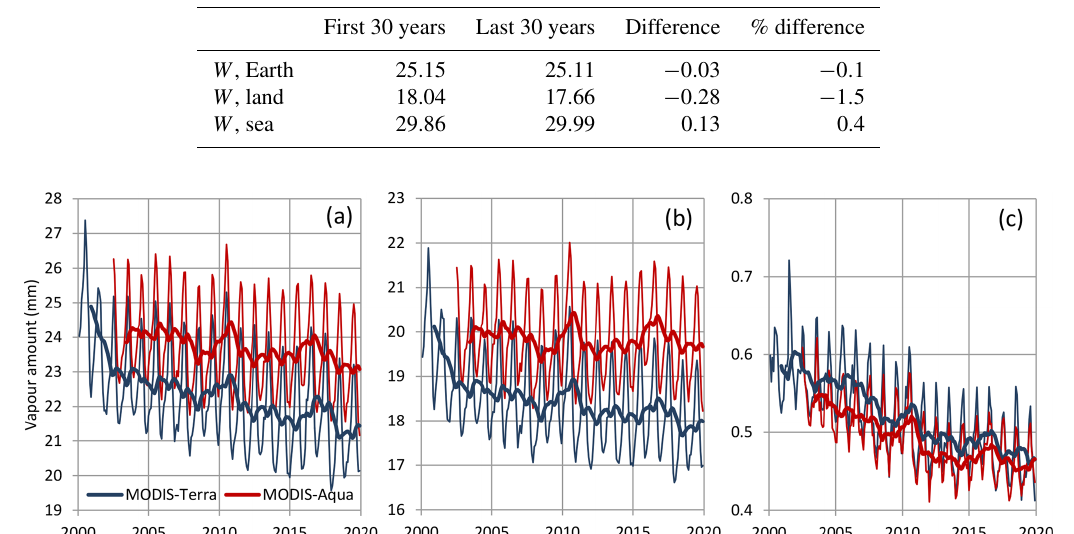
Table 5. Water vapour amount ( W ) in mm per 30-year climatic period and the resulting differences. Data are from the NCEP–NCAR reanalysis.